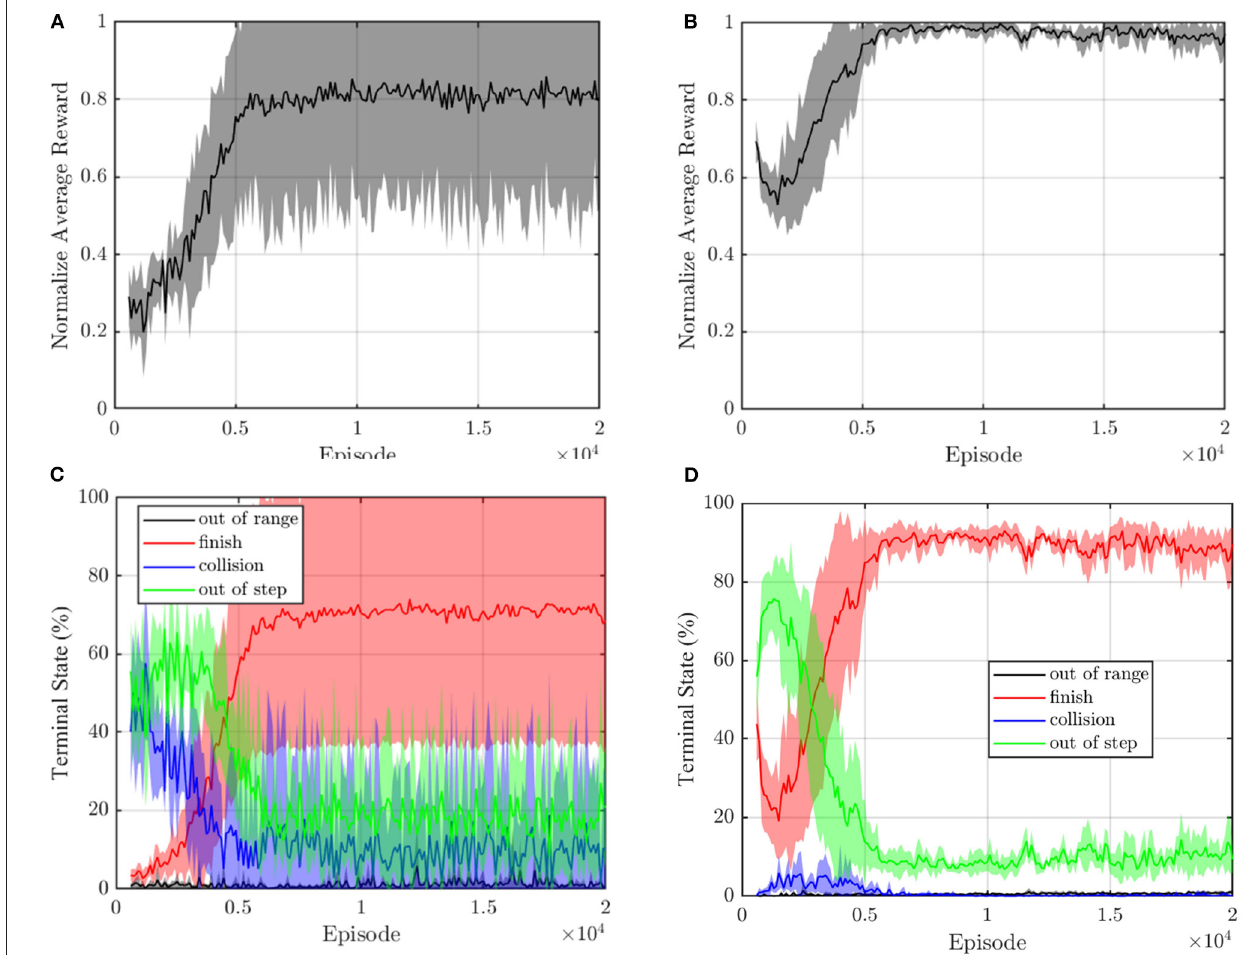
FIGURE 7 | The normalized average reward of DQN (A) without and (B) with reward shaping. The terminal state during train process (C) without and (D) with reward reshaping. The translucent shadow their